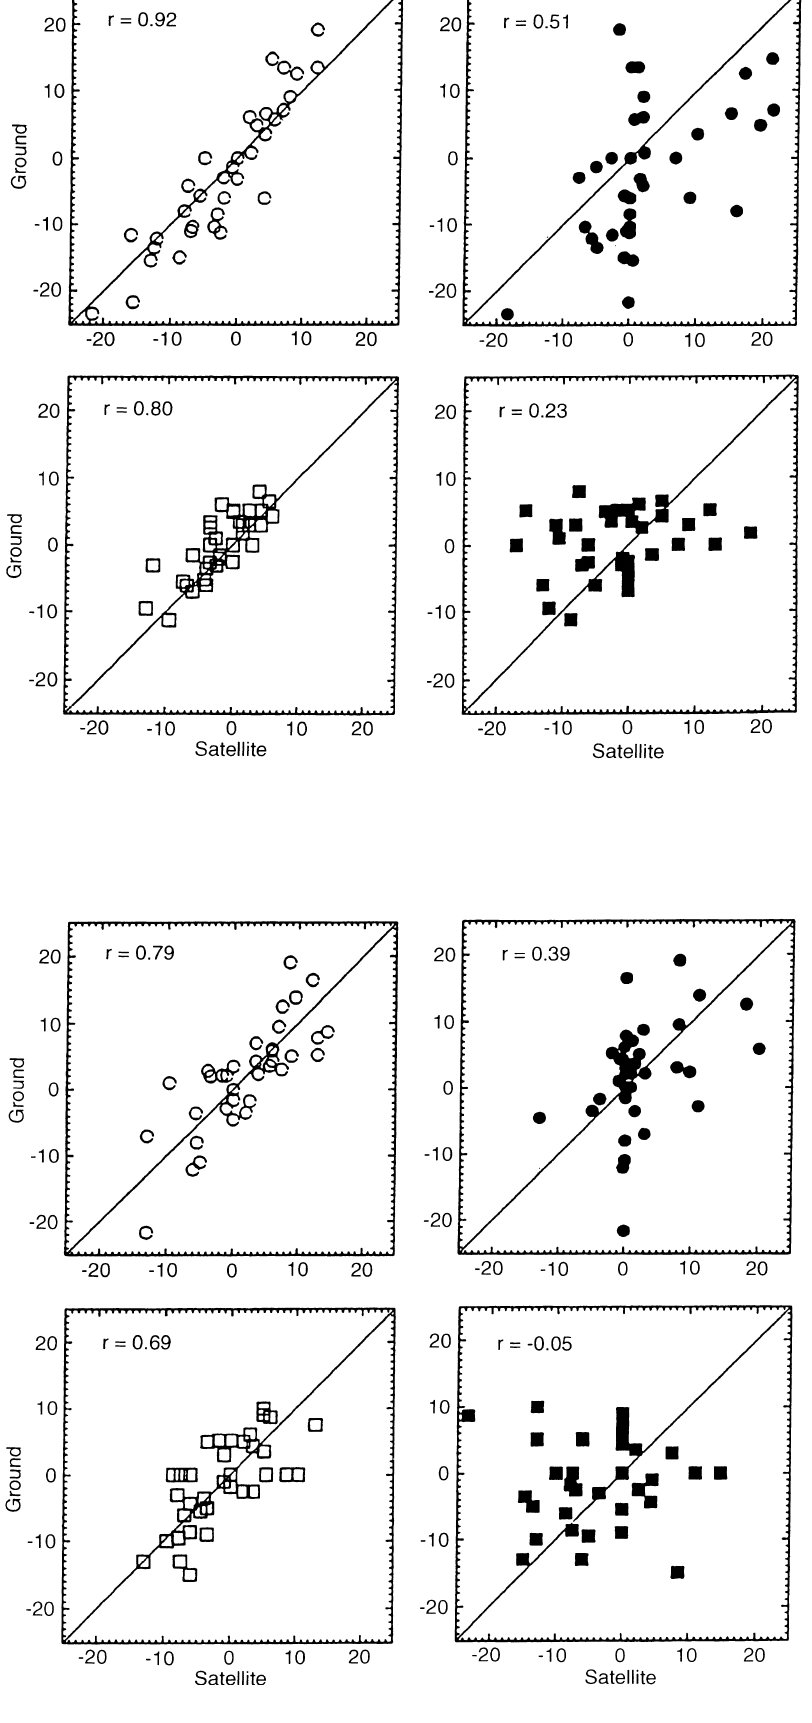
Fig. 6. The same as Fig. 5, except for a satellite inclination of 70 (cid:14) and the combined data set consisting of the eastward and northward wind components over Saskatoon, and the northward wind component over Hawaii. The standard deviations as defined for Fig. 5 are 5.00, 8.07, 5.11, and 11.33 m/s, and the respective linear correlation coe(cid:129)cients are 0.79, 0.39, 0.69,